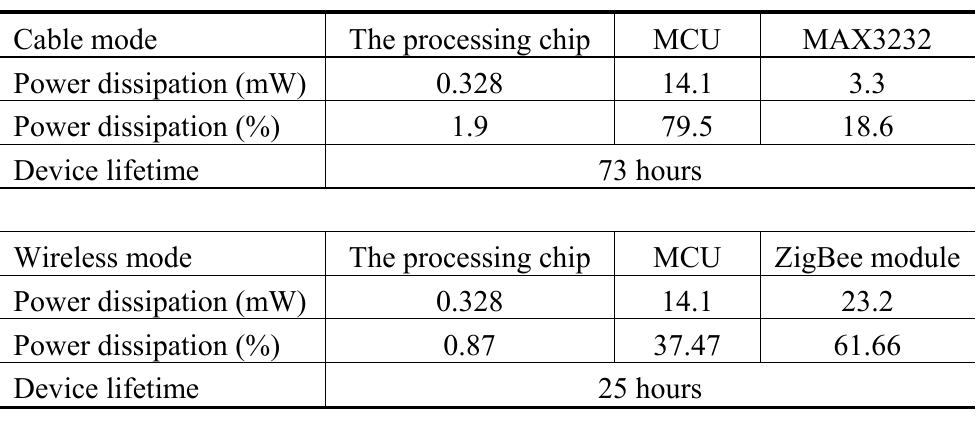
Table 4. Two modes’ power consumption of the proposed acquisition device integrated with commercial peripheral